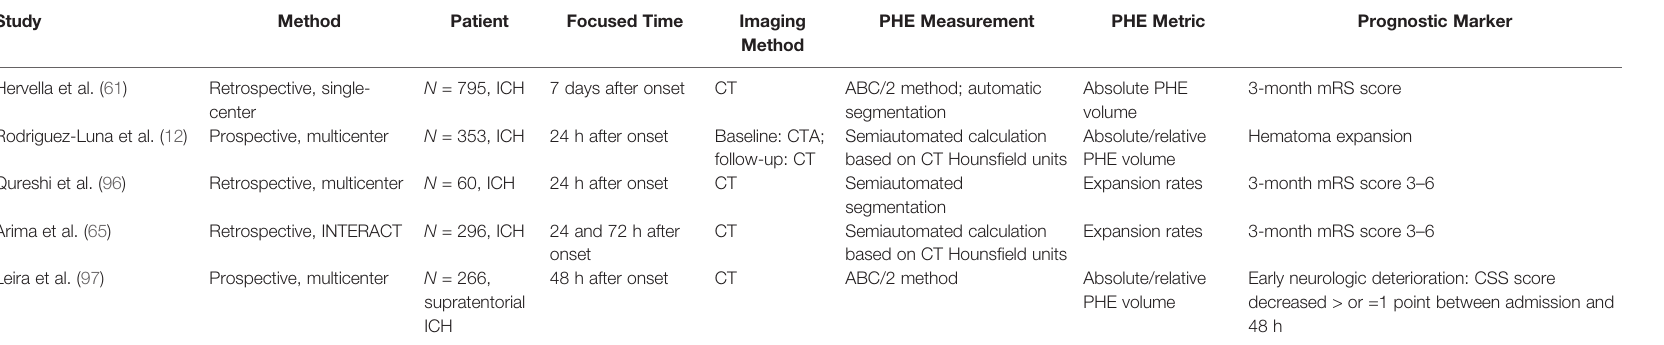
TABLE 3 | Summary of prognostic research of PHE — the PHE was not associated with ICH outcome.